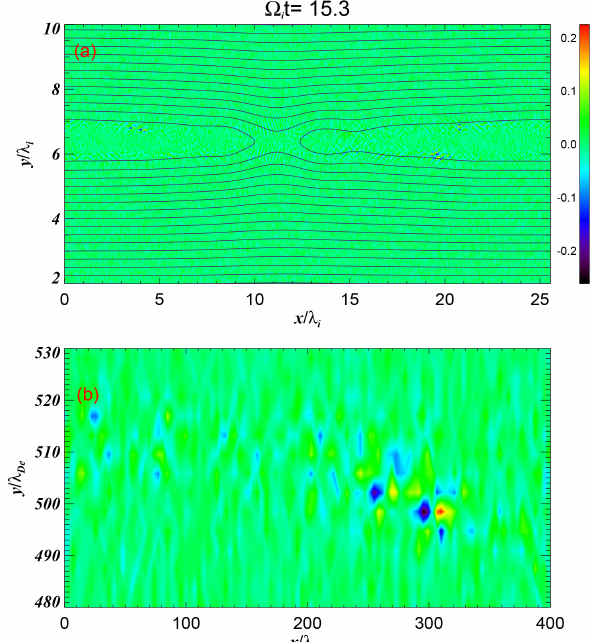
Figure 1. The electric field parallel to the local magnetic filed E // and magnetic field lines at t(cid:127) i = 15 . 3 (a) , the magnification of the left-hand plane (b) .